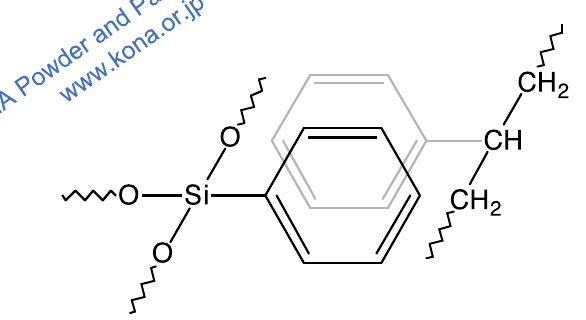
Fig. 3 . π - π interaction in hybrid